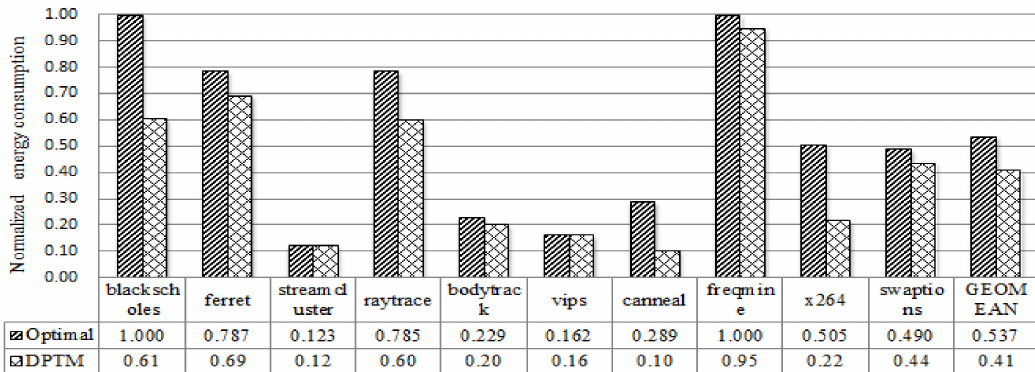
Figure 8. Relative energy consumption compared to OS default mapping